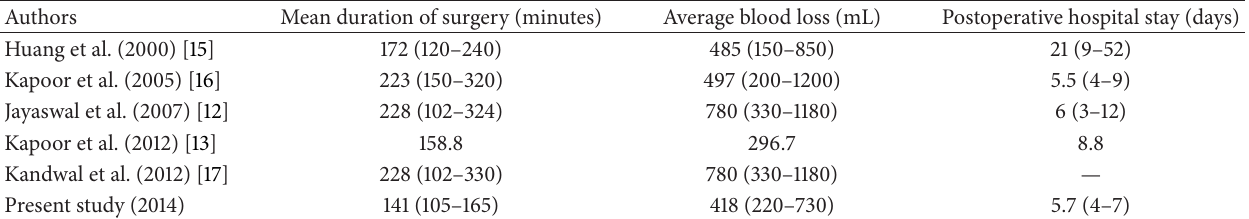
Table 3: Comparison of mean duration of surgery, average blood loss, and postoperative hospital stay with other